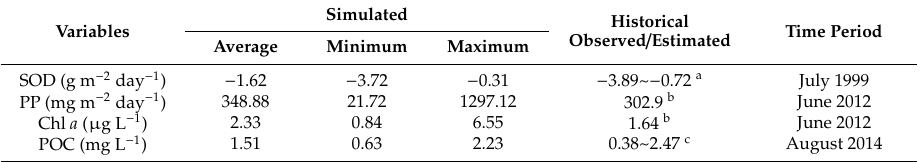
Table 3. Comparison between the model-simulated and historical observed / estimated values during summer in the nearshore area of the Pearl River estuary (PRE, as shown in Figure 6d): sediment oxygen demand (SOD), where negative values represent the DO consumption rate; primary production (PP); chlorophyll a (Chl a ) concentration; and particulate organic carbon (POC)